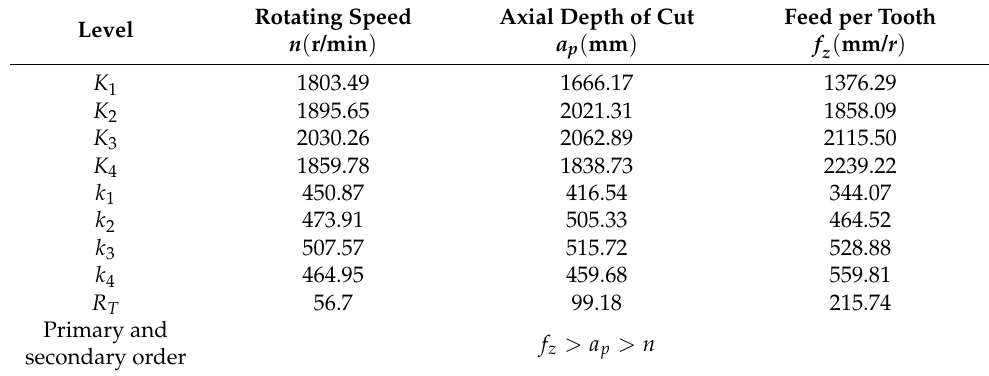
Table 4. Cutting temperature ( T ) range analysis